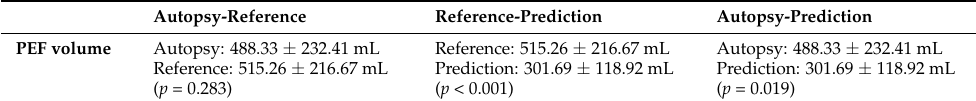
Table 6. Volume of pericardial effusion identified on CT using autopsy, reference, and model.